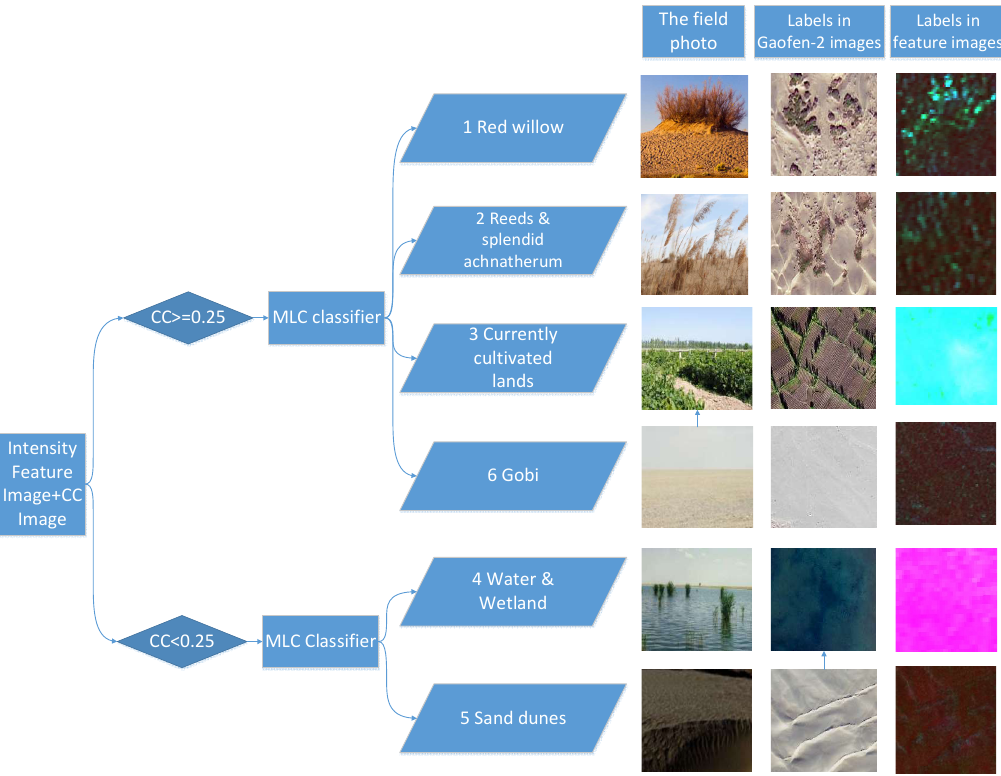
Figure 4. Classification approach and resulting classes based on the intensity feature image and the coherence coefficient (CC) information. A CC value of 0.25 is the threshold used to obtain the first classification, followed by the MLC to obtain the second classification and the final six classes including red willow (class 1), reeds & splendid achnatherum (class 2), currently cultivated lands (class 3), water & wetland (class 4), sand dunes (class 5) and Gobi (class 6). The field photos and the labels in the Gaofen-2 images and the intensity feature images for the different classes are shown.